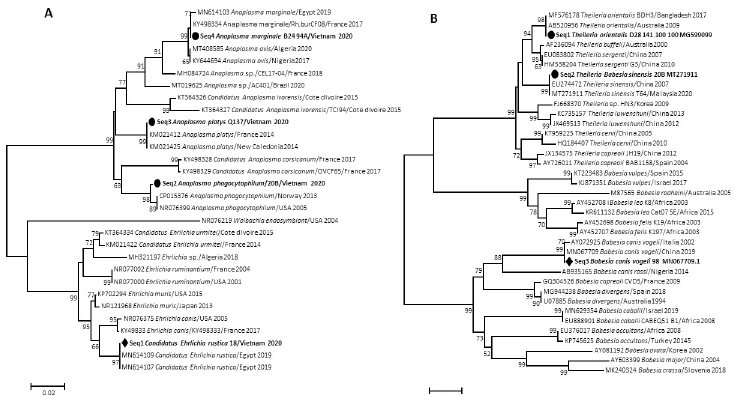
Fig 4. 23S rRNA gene-based phylogenetic analysis of strains identified in this study. Phylogenetic tree highlighting the position of A . phagocytophilum, A . marginale , A . platys , and E . rustica identified in our study are close to their homologues available in GenBank (A). 18S rRNA gene-based phylogenetic analysis of strains identified in the present study. Phylogenetic tree highlighting the position of B . vogeli , T . sinensis , and T . orientalis relative to their correspondence available in GenBank